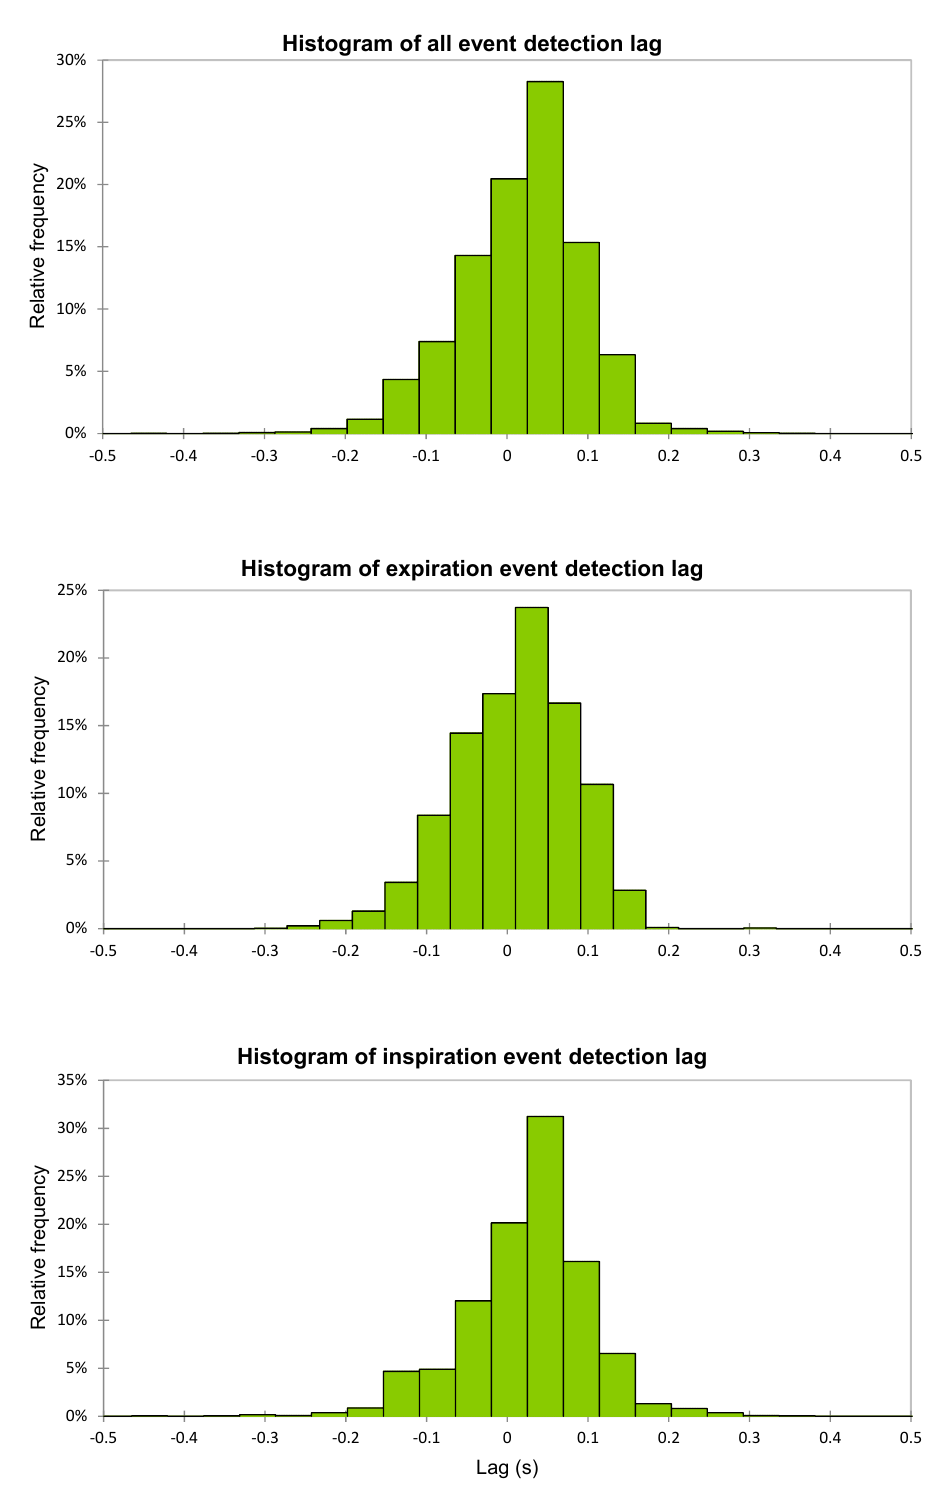
Figure 6. Histogram of event detection lags for full dataset, expiration, and inspiration events. Table 3. FR detection accuracy.